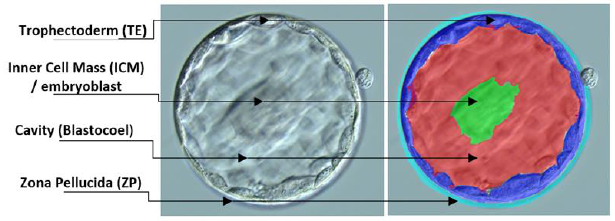
Figure 3. Blastocyst formation at Day 5-4AA (hatching) and development into ICM, TE, ZP and